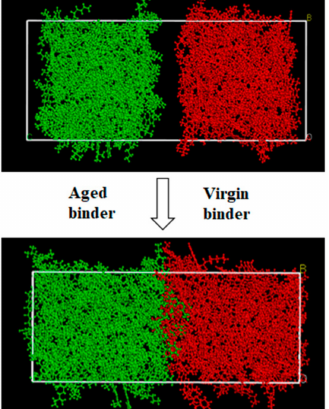
Figure 3. Molecular diffusion model of virgin and aged asphalt.